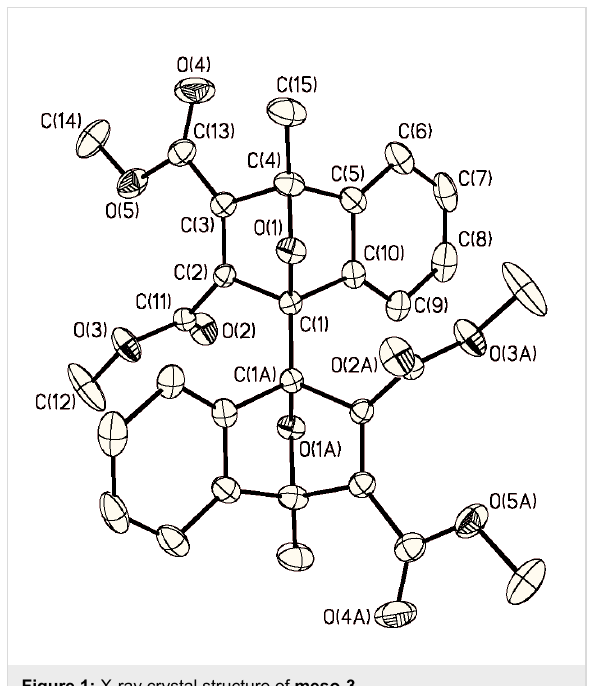
Figure 1: X-ray crystal structure of meso-3 .